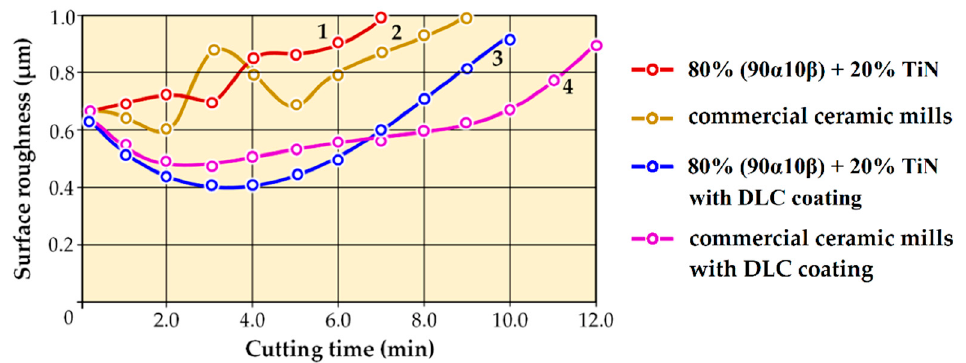
Figure 16. Dependence of flank face wear on the operating time of ceramic end mills before and after DLC coating deposition: (1) 80% (90 α 10 β ) + 20% TiN; (2) commercial ceramic mills; (3) 80% (90 α 10 β ) + 20% TiN with DLC coating; and (4) commercial ceramic mills with DLC coating.